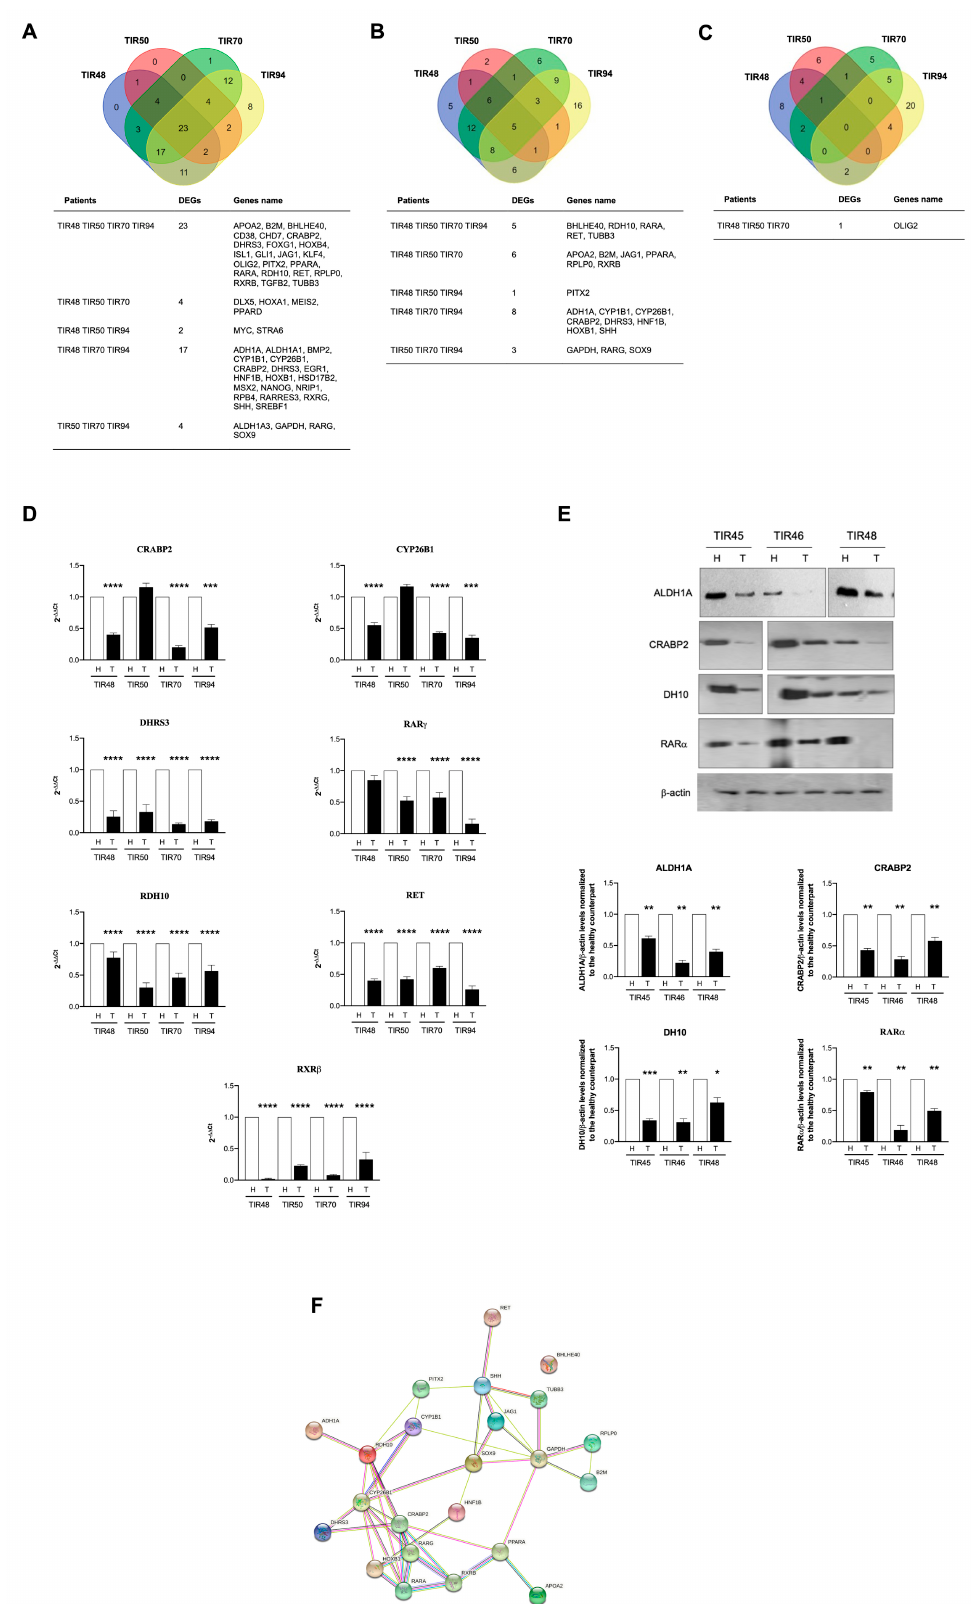
Figure 2. Transcriptome data analysis derived from PTC patients. Four PTC patients (i.e., TIR48, TIR50, TIR70, and TIR94) were analyzed by comparing the healthy and pathological lobes. ( A )